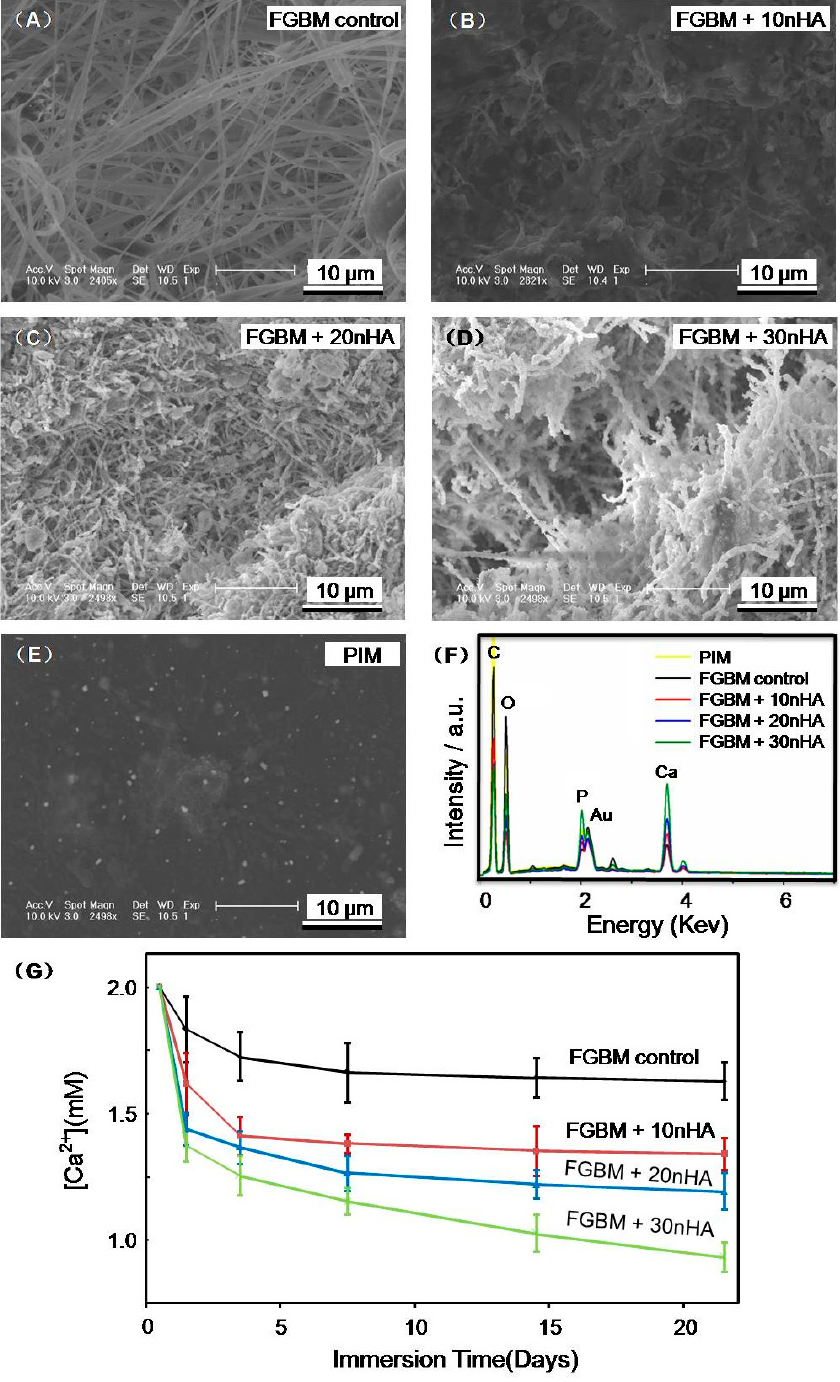
Figure 6. Apatite deposition on FGBM with different content of nHA after soaking in SBF for 21 days: ( A ) FGBM control; ( B ) FGBM + 10 nHA; ( C ) FGBM + 20 nHA; ( D ) FGBM + 30 nHA; and ( E ) PIM. The